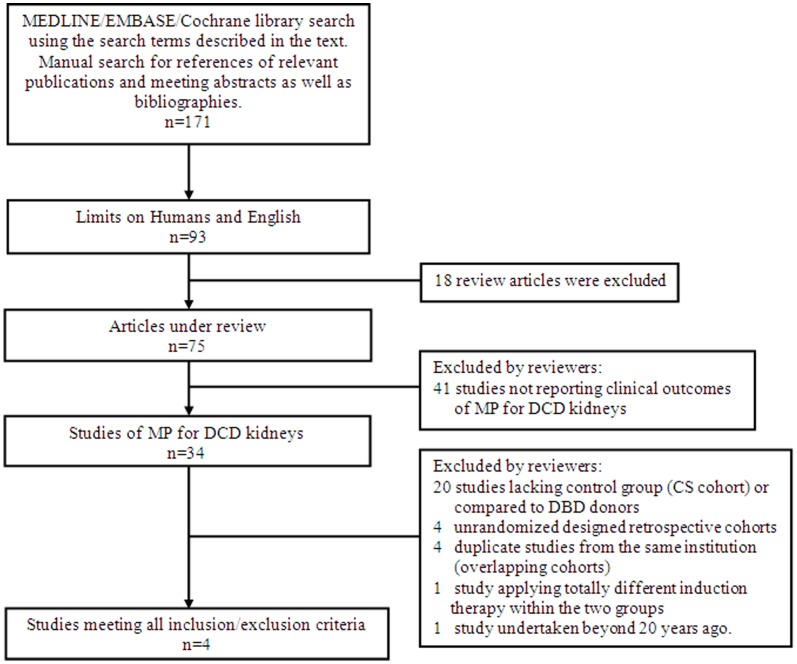
Search algorithm and study selection outcomes.